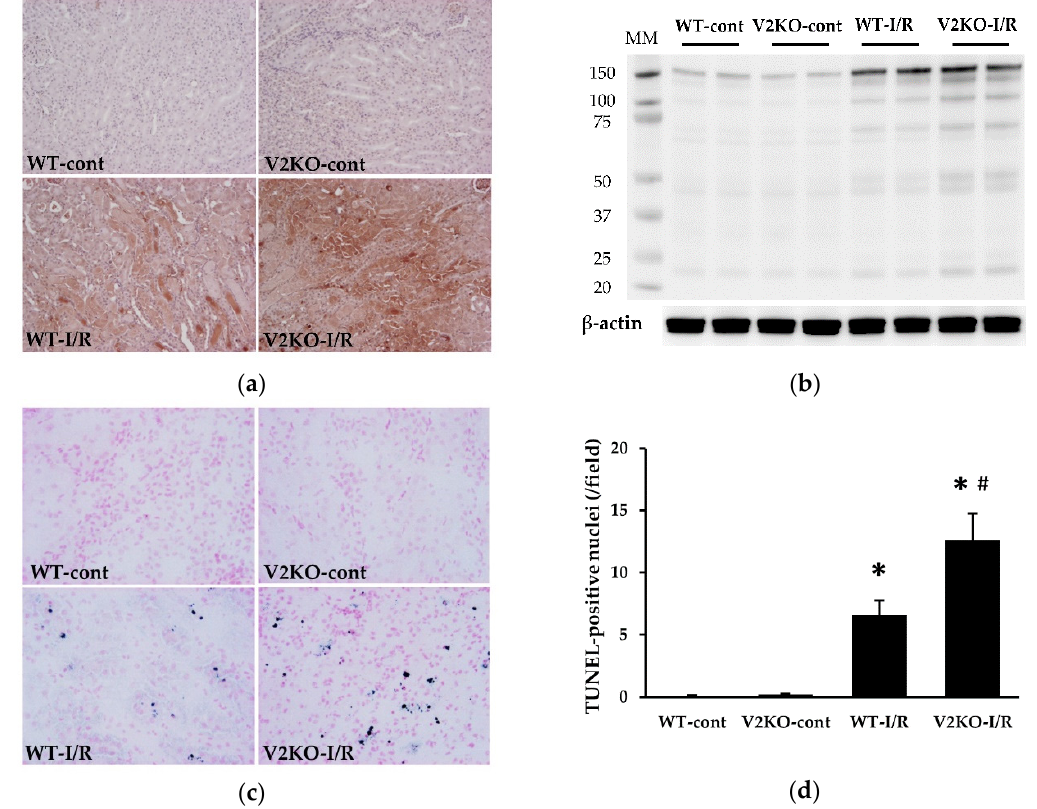
Figure 2. VASH2 deficiency promoted oxidative stress marker accumulation and apoptosis in I/R-induced acute kidney injury (AKI). ( a ) Immunohistochemical images of malondialdehyde (MDA) accumulation in the kidney (original magnification, ×200). ( b ) Immunoblots for 4-hydroxy-nonenal (4-HNE) and β -actin. Each lane was loaded with 40 µg of protein. MM, molecular weight. ( c ) Representative images for terminal uridine deoxynucleotidyl transferase-mediated dUTP nick-end labeling (TUNEL) staining in the kidney. The apoptotic nuclei were stained blue. ( d ) A larger number of TUNEL-positive nuclei were found in V2KO-I/R mice than in WT-I/R mice. n = 6 for each group. * p < 0.01 vs. WT-cont, # p < 0.05 vs. WT-I/R. Each column shows the mean ± SD.